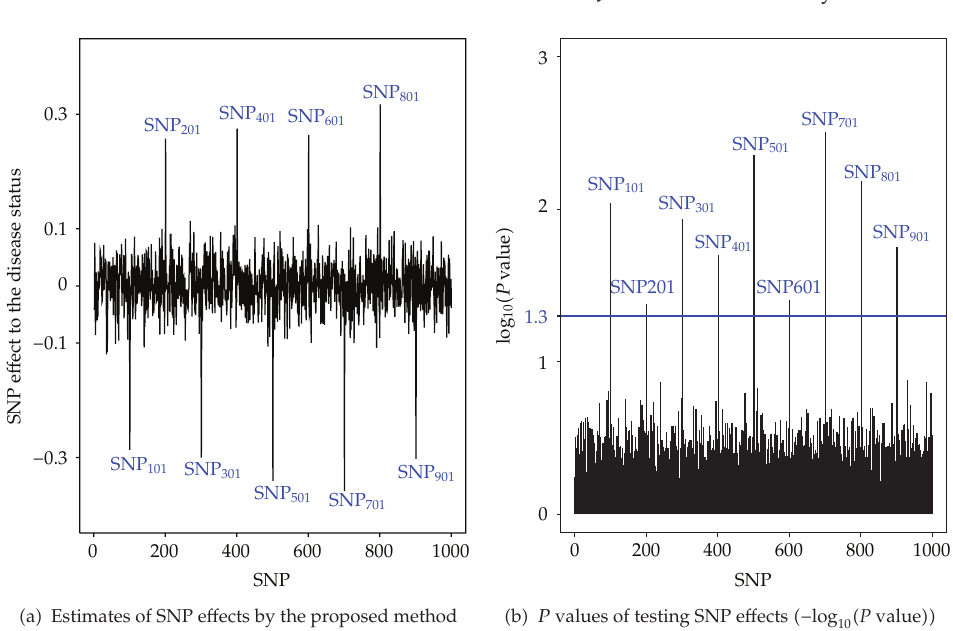
Figure 1: Analysis of the simulated data sets with multinomial ordinal probit model with